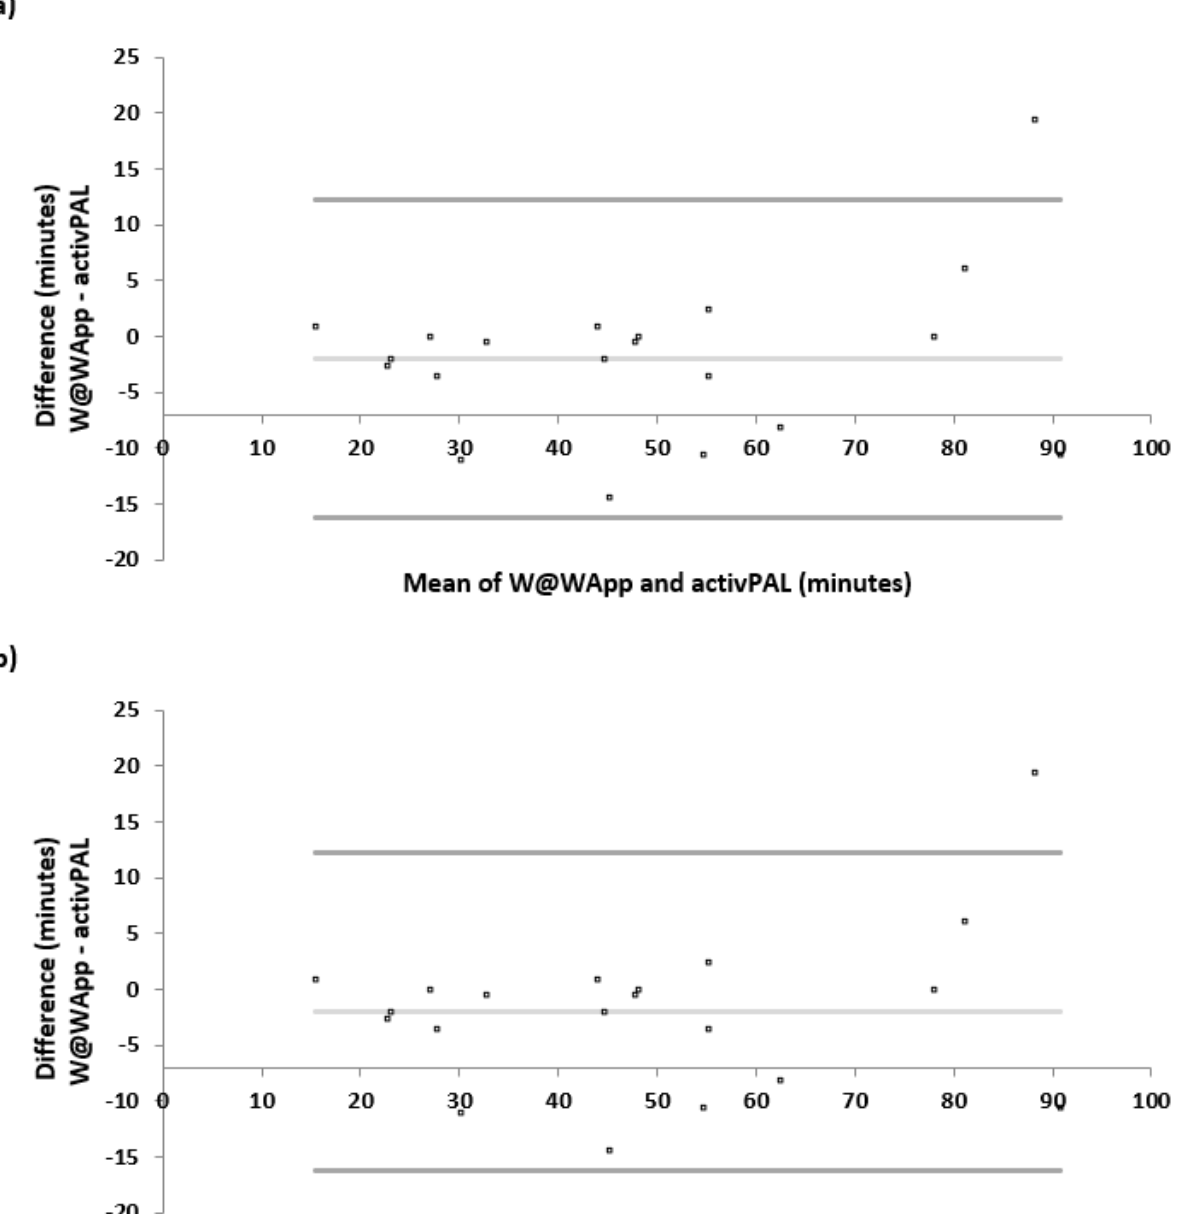
Figure 4. Bland-Altman plots of absolute agreement for (A) stationary time (sitting+standing) and (B) upright time (standing+stepping), derived